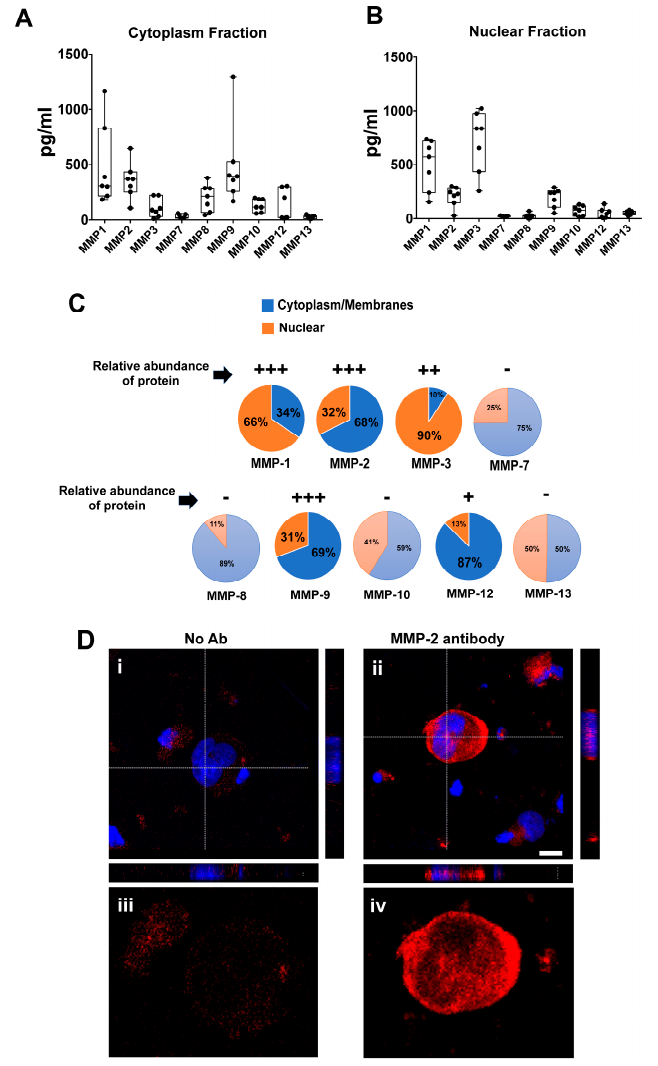
Figure 2. Subcellular localization of MMPs in primary human Megakaryocytes. ( A , B ) Profiling and quantification of MMPs in cytoplasm ( A ) and nuclear ( B ) fractions of 2 × 10 6 megakaryocytes at